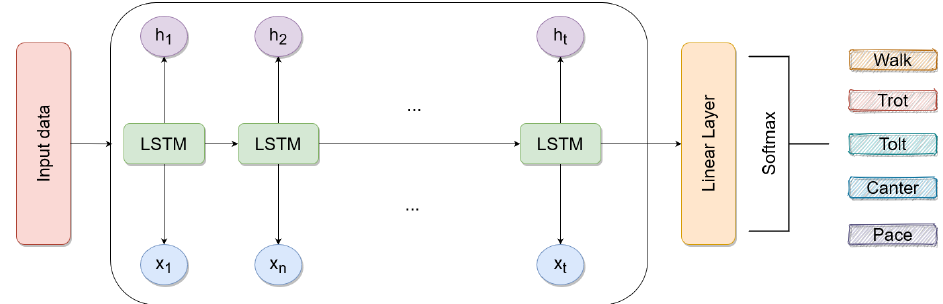
Figure 7. The model architecture used in this